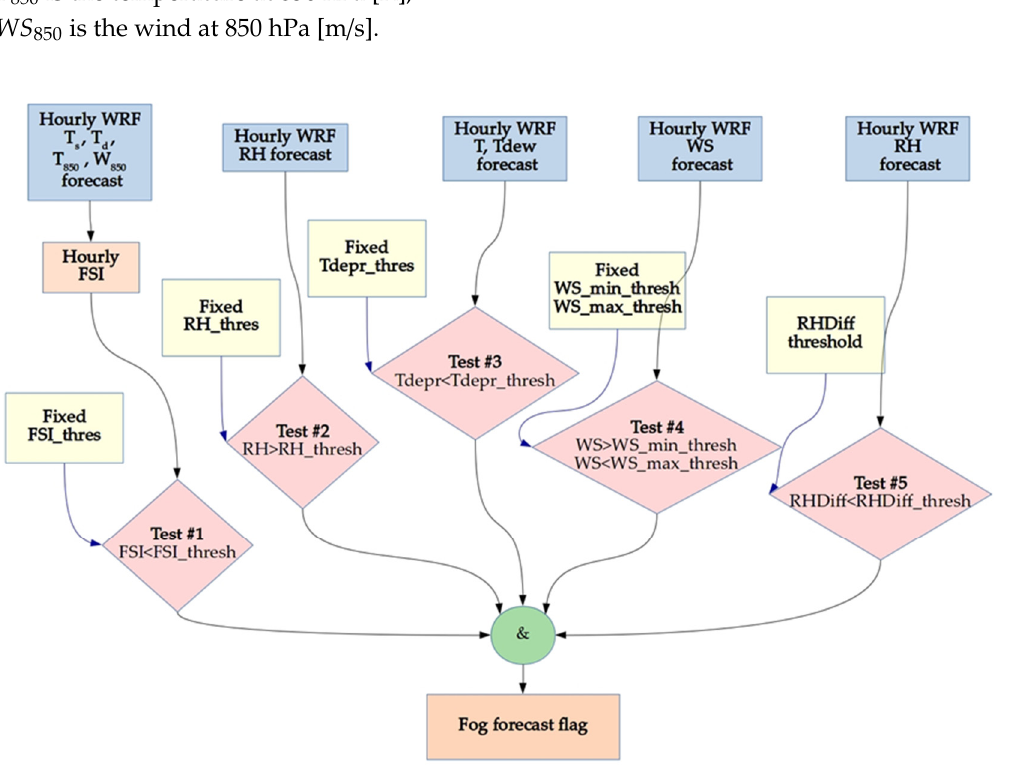
Figure 3. Block diagram of the multitest-based method for forecasting fog (MBFog) using WRF out- put. Thresholds are fixed after site-specific climatological study (test #2, #3, #4), statistical study (test #1) or literature review (test